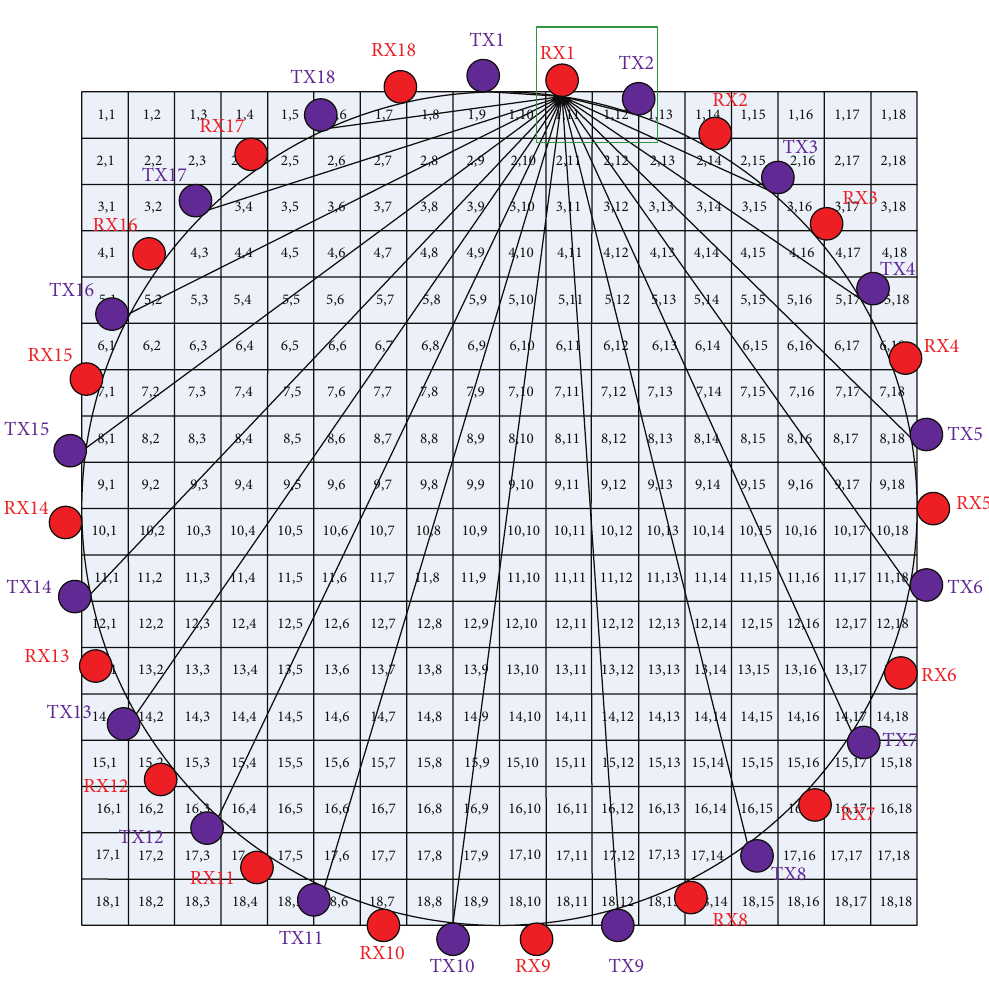
Figure 8: The analysis of transmitting light to receiver